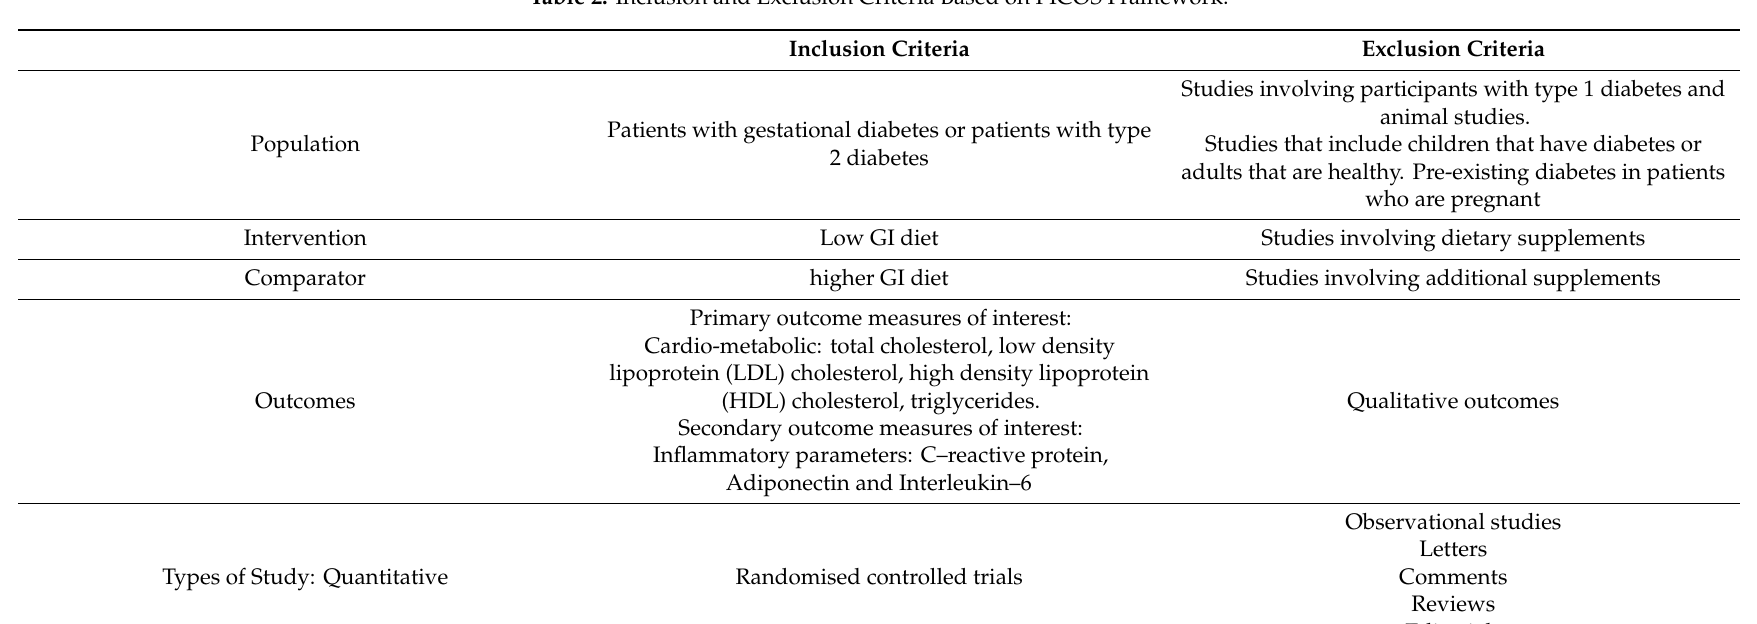
Table 2. Inclusion and Exclusion Criteria Based on PICOS